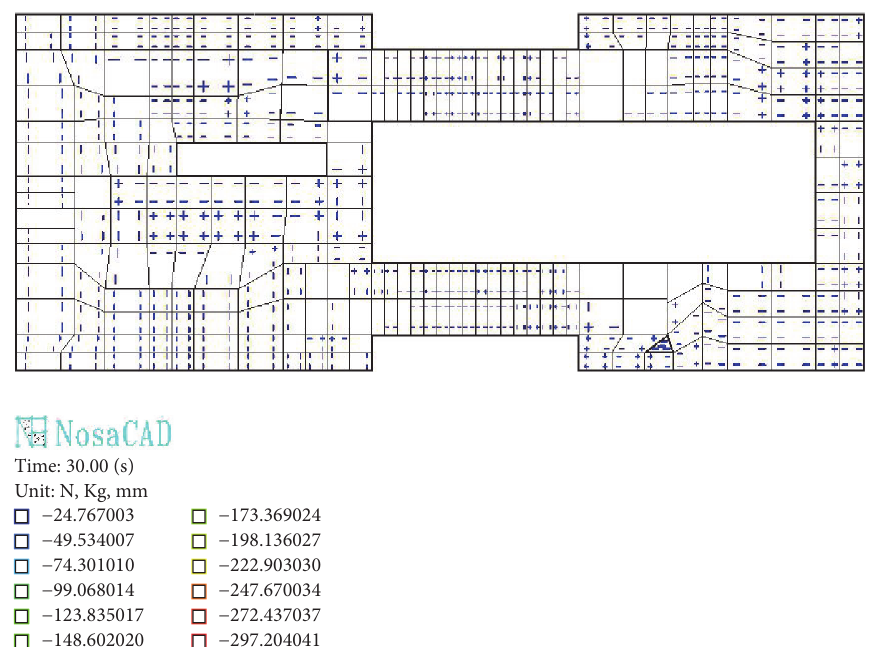
Figure 24: Tension stress envelopes of the rebar in the slab at the connecting floor under major earthquakes (NosaCAD).